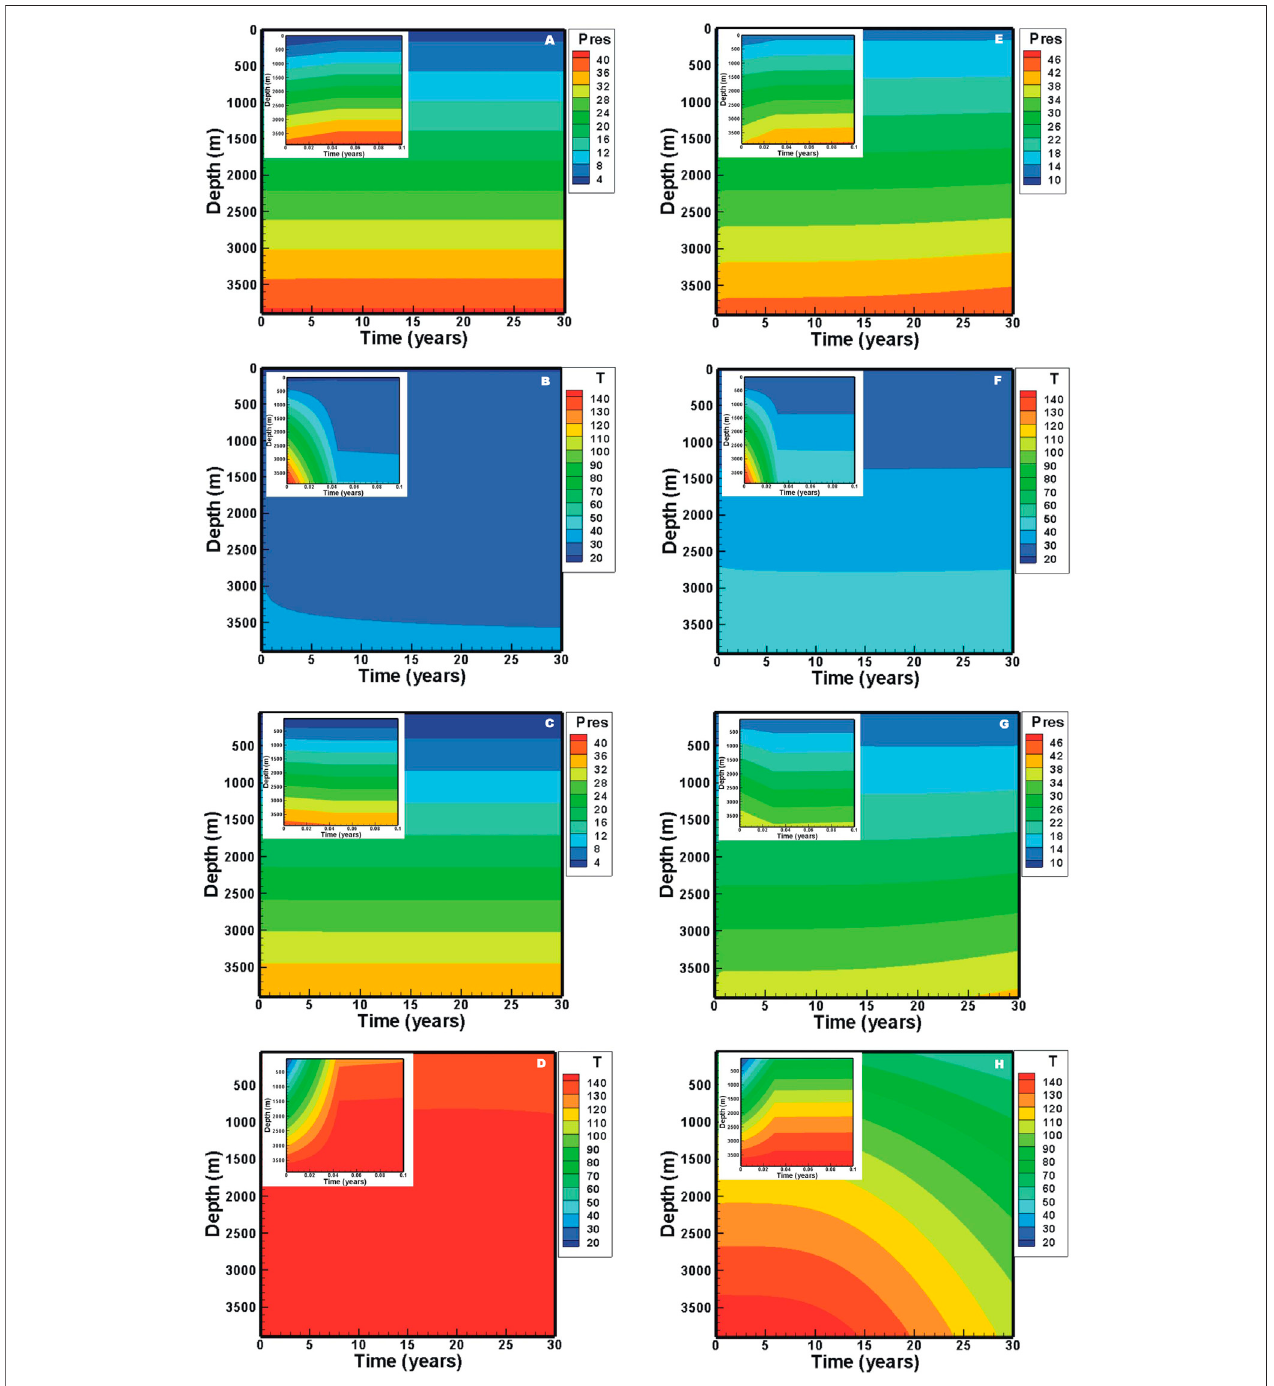
FIGURE5| Evolutionofpressureandtemperature distributions inthewellbore: (A) pressureand (B) temperature forH 2 Ointheinjectionwell, (C) pressureand (D) temperatureforH 2 Ointheproductionwell, (E) pressureand (F) temperatureforCO 2 intheinjectionwell, (G) pressureand (H) temperatureforCO 2 intheproductionwell.